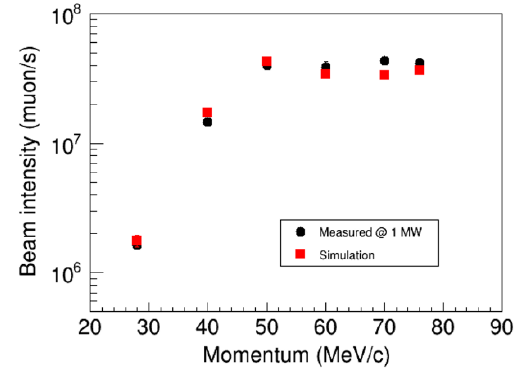
Fig. 5. Intensity of negative muons as a function of momentum of muons